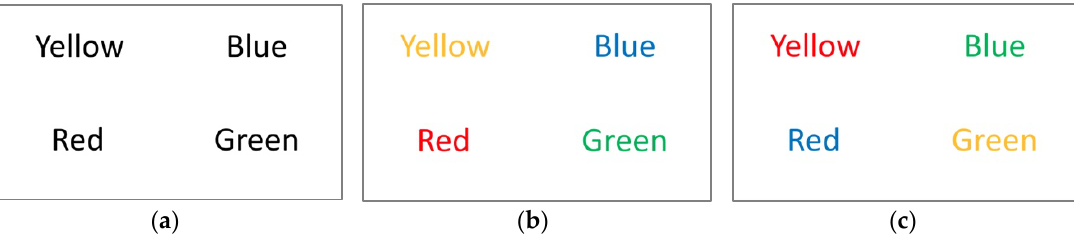
Figure 5. Black and white color words ( a ); matching color words ( b ); and non-matching color words ( c ) displayed respectively during phases PHA, PHB and PHC of the Stroop test.